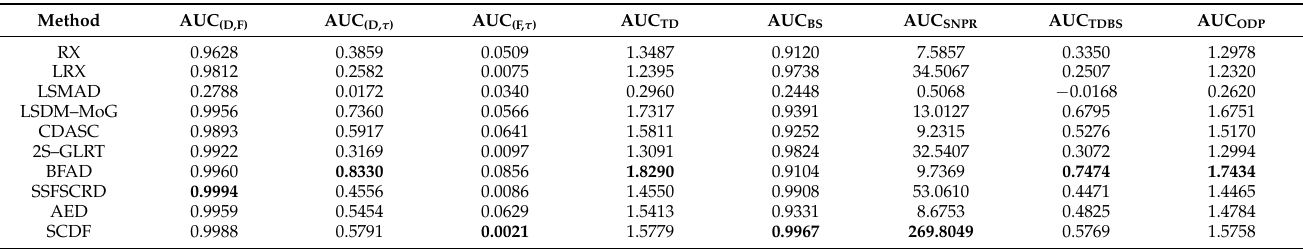
Table 3. Comparison of AUC performance of different methods on the urban dataset.